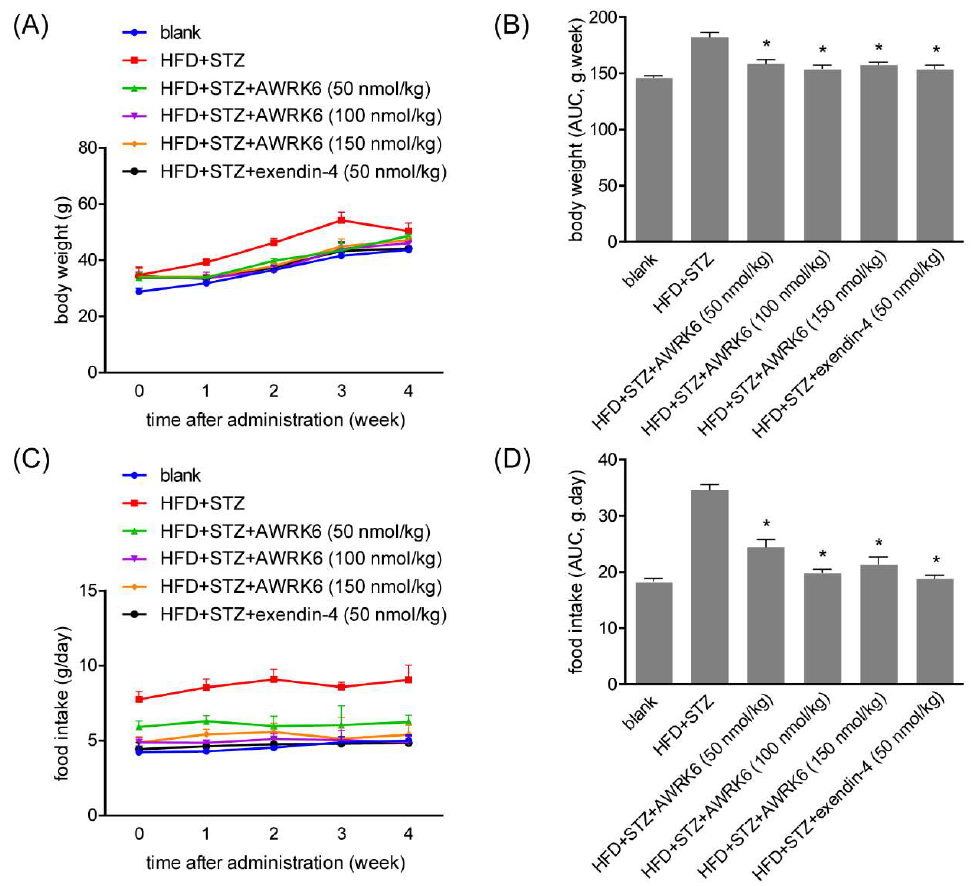
Figure 3. AWRK6 decreased food intake and body weight. ( A ) The body weight of diabetic mice treated with AWRK6 during 4 weeks. ( B ) The AUC analysis of AWRK6 on body weight of diabetic mice during 4 weeks. ( C ) The food intake of diabetic mice treated with AWRK6 during 4 weeks. ( D ) The AUC analysis of AWRK6 on food intake of diabetic mice during 4 weeks. The error bar indicates standard deviation. * p < 0.05 compared with the diabetes groups.